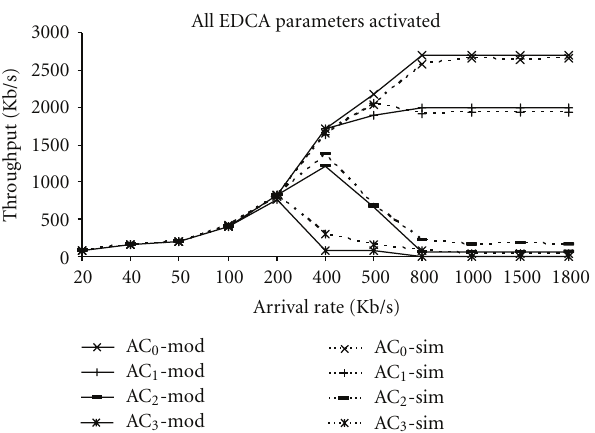
Figure 21: Achievable throughput per AC—all parameters acti- vated.